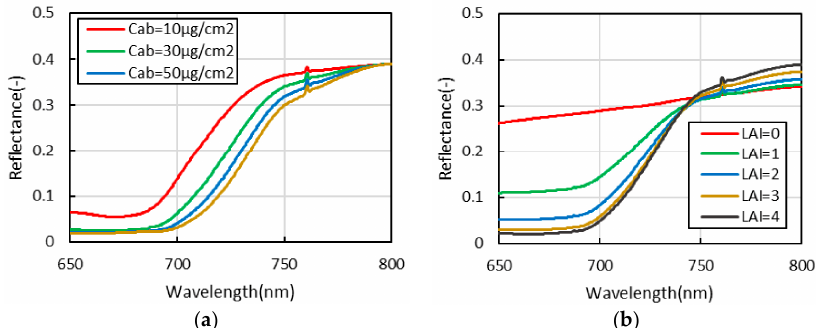
Table 2. Parameters of the vegetation spectrum with different leaf area indices simulated by FluorMOD.